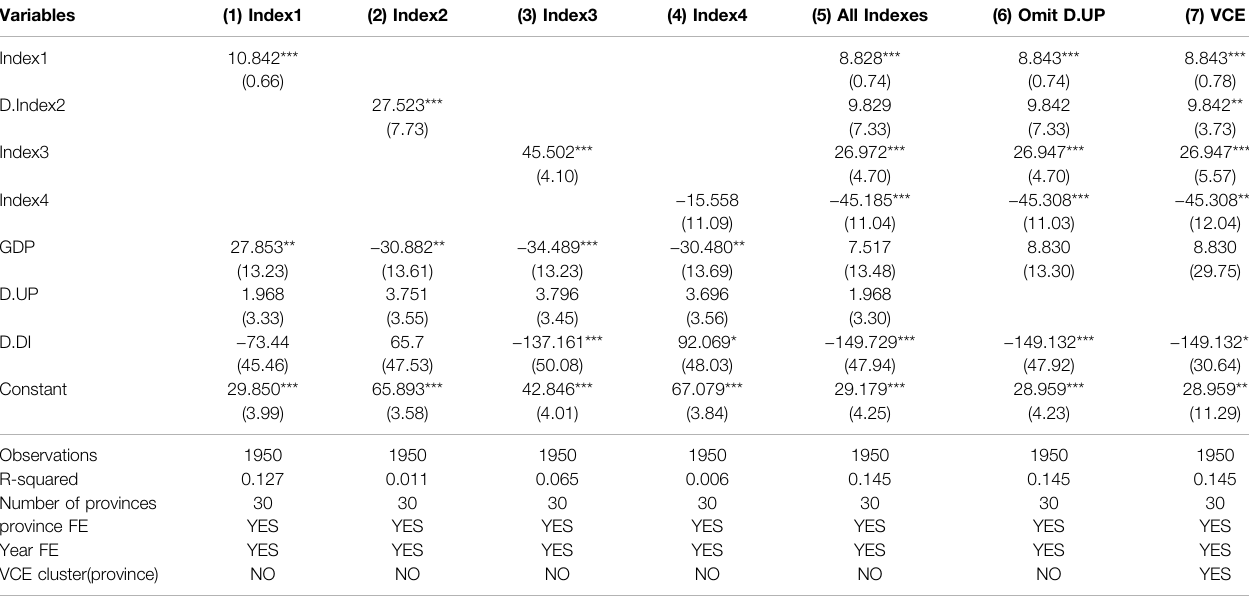
TABLE 4 | Model estimation results using Baidu search index in the same month.